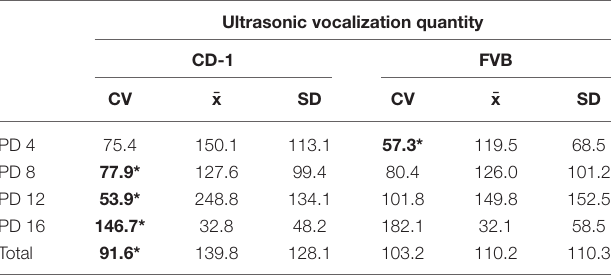
FIGURE 2 | Call type composition for CD-1 and FVB mice. PD 8 CD-1 mice emit more complex, frequency steps, and composite call types than FVB mice but less downward, two-component, and chevron call types. No differences between groups were found for short, upward, and flat call types. *** p < 0.001. TABLE 1 | Variability in USV production per day and in total between